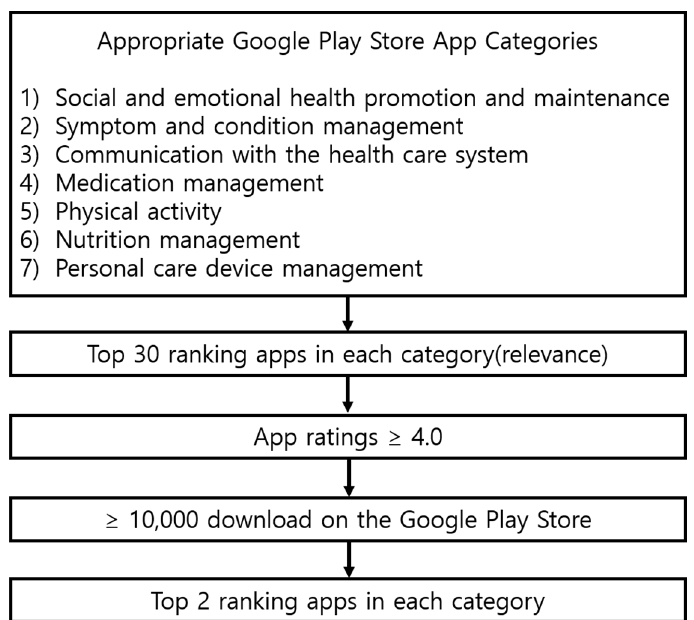
Figure 1. Inclusion and exclusion criteria for 12 smartphone applications for older adults to use during the COVID-19 pandemic.